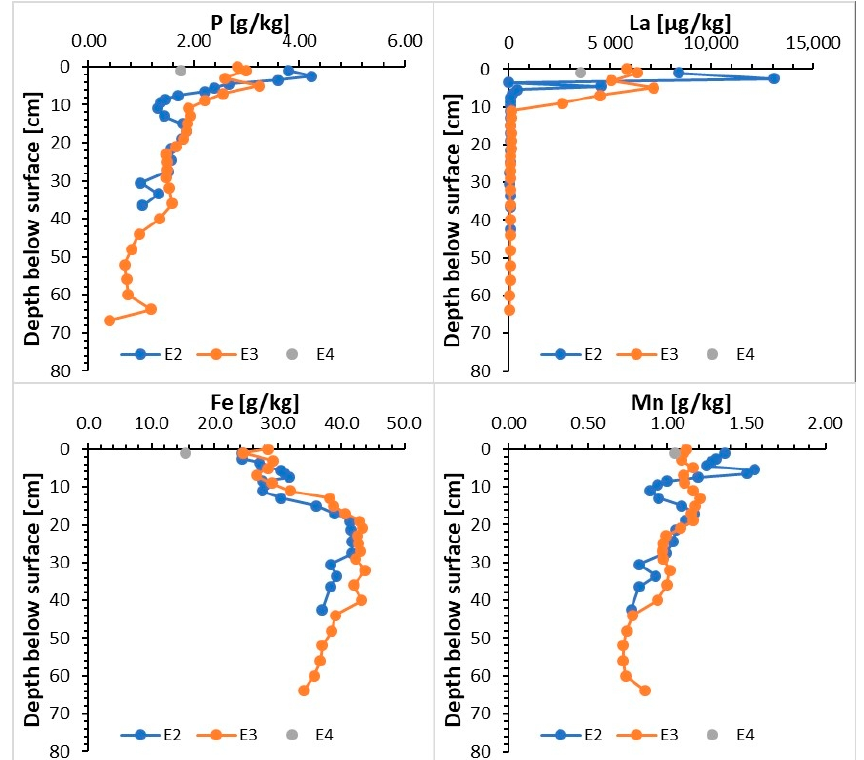
Figure 2. Phosphorous content of Lake Eichbaumsee in spring and autumn between 2004 and Figure 7. Distribution of phosphorous (P), lanthanum (La), iron (Fe), and manganese (Mn) in sedi- 2015. Numbers with arrows indicate the phosphorous increase (kg) between spring and autumn. ments cores E2, E3, and The application of Bentophos ® in the winters 2011 through 2013 did not lead to a long-term reduction of the lake phosphorous content (modified from [28]).